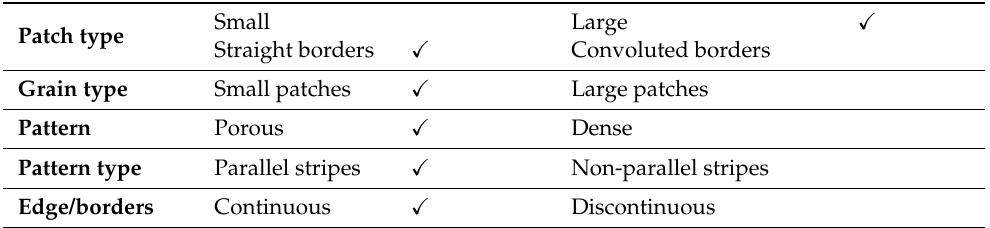
Table 4. Formal functional features of the solar landscape for Agrivoltaico.